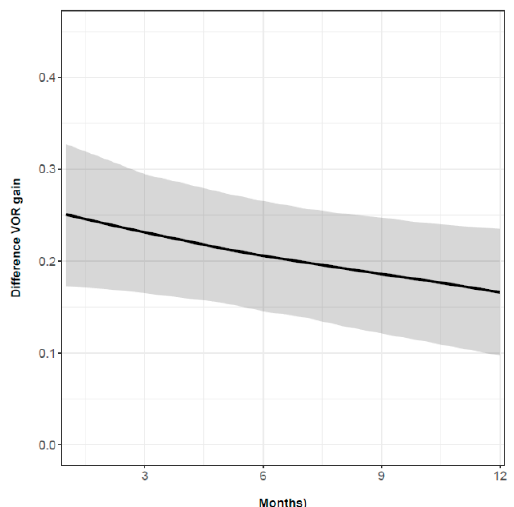
Figure 1. Vestibulo-ocular reflex (VOR) gain difference over time. Vertical axis: VOR gain difference. Horizontal axis: time in months. The line shows the value of the VOR gain difference estimate, and the shaded area indicates the confidence interval (IC).